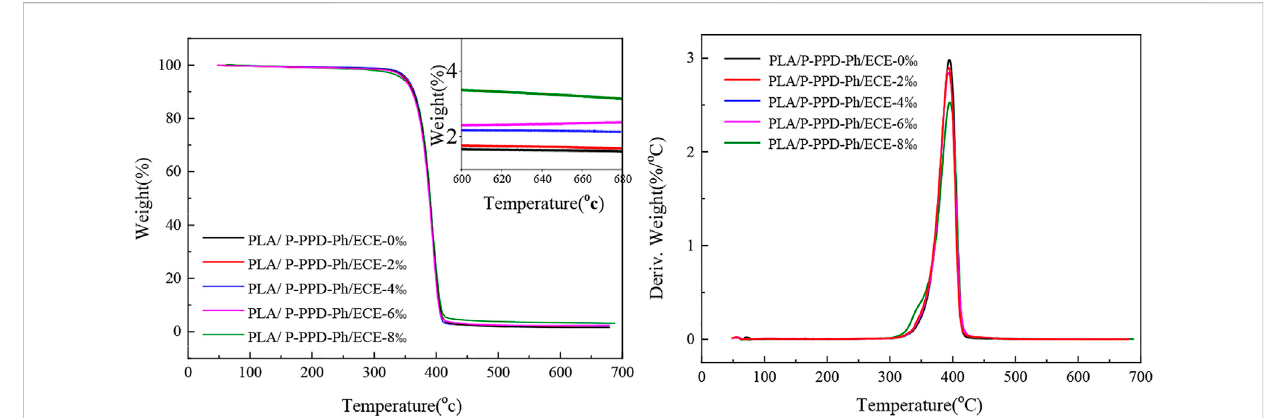
FIGURE 7 TGA and DTG curves of PLA/P-PPD-Ph/ECE conjugated fl ame retardant